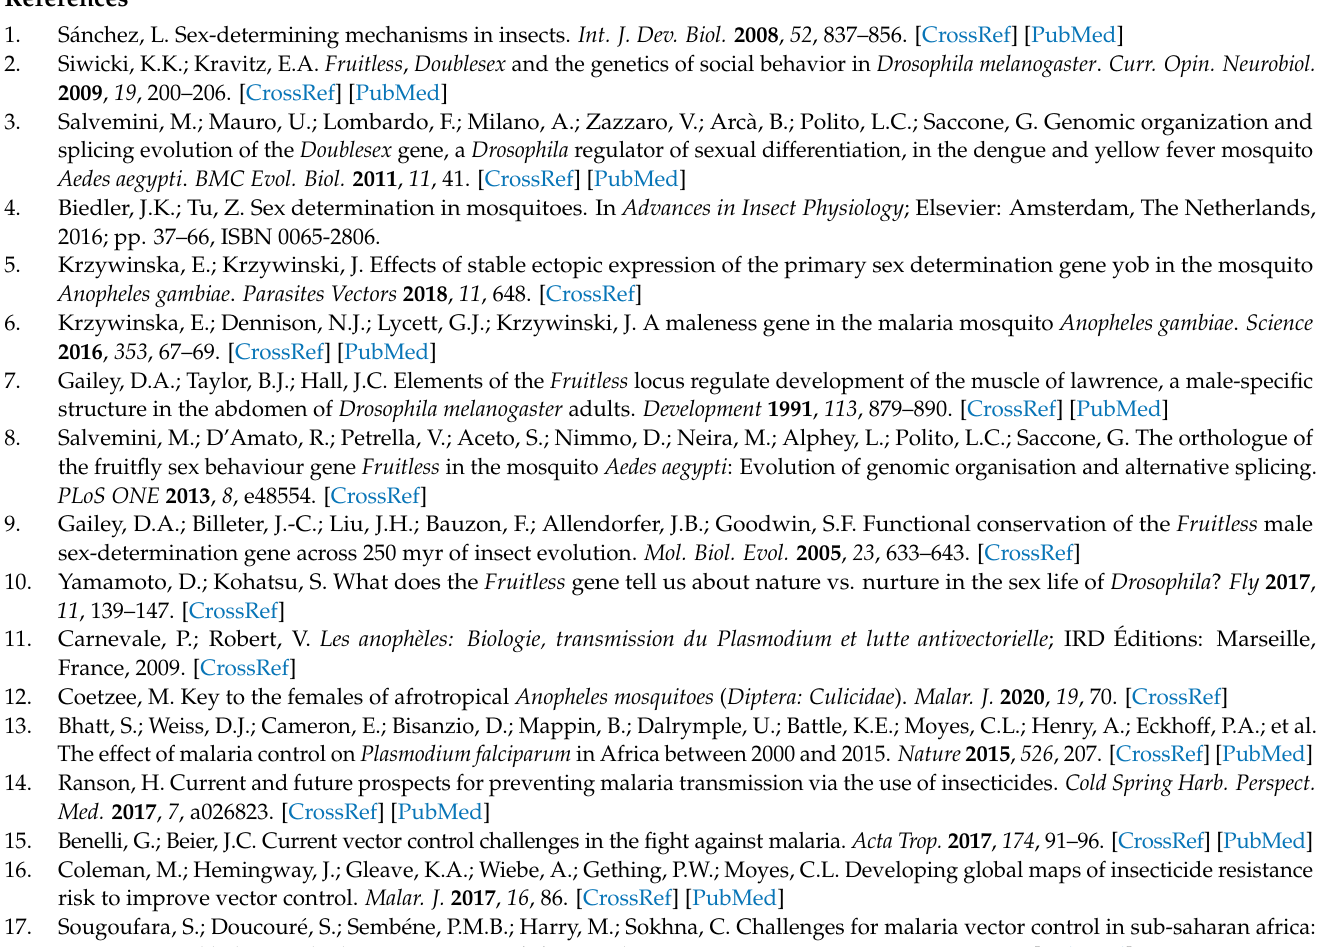
the 3′ and 5′ UTR regions, and the simple line is the intronic region); lower figure shows the conservation score (blue line) and the nucleotide diversity (dark fill) plot. The conservation score remains high in the exonic regions compared to the intronic ones, as it is found in the fru gene.